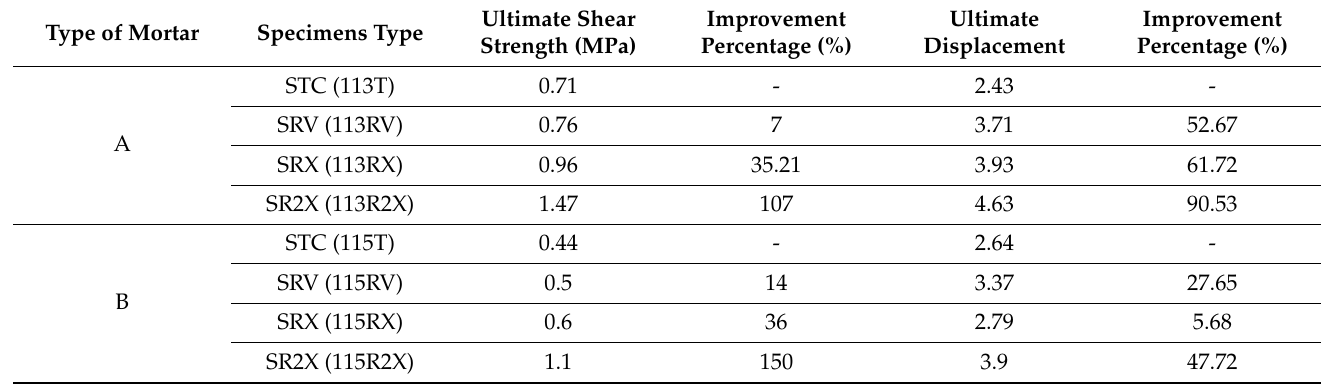
Table 5. Ultimate shear strength of non-strengthened and strengthened masonry shear triplet